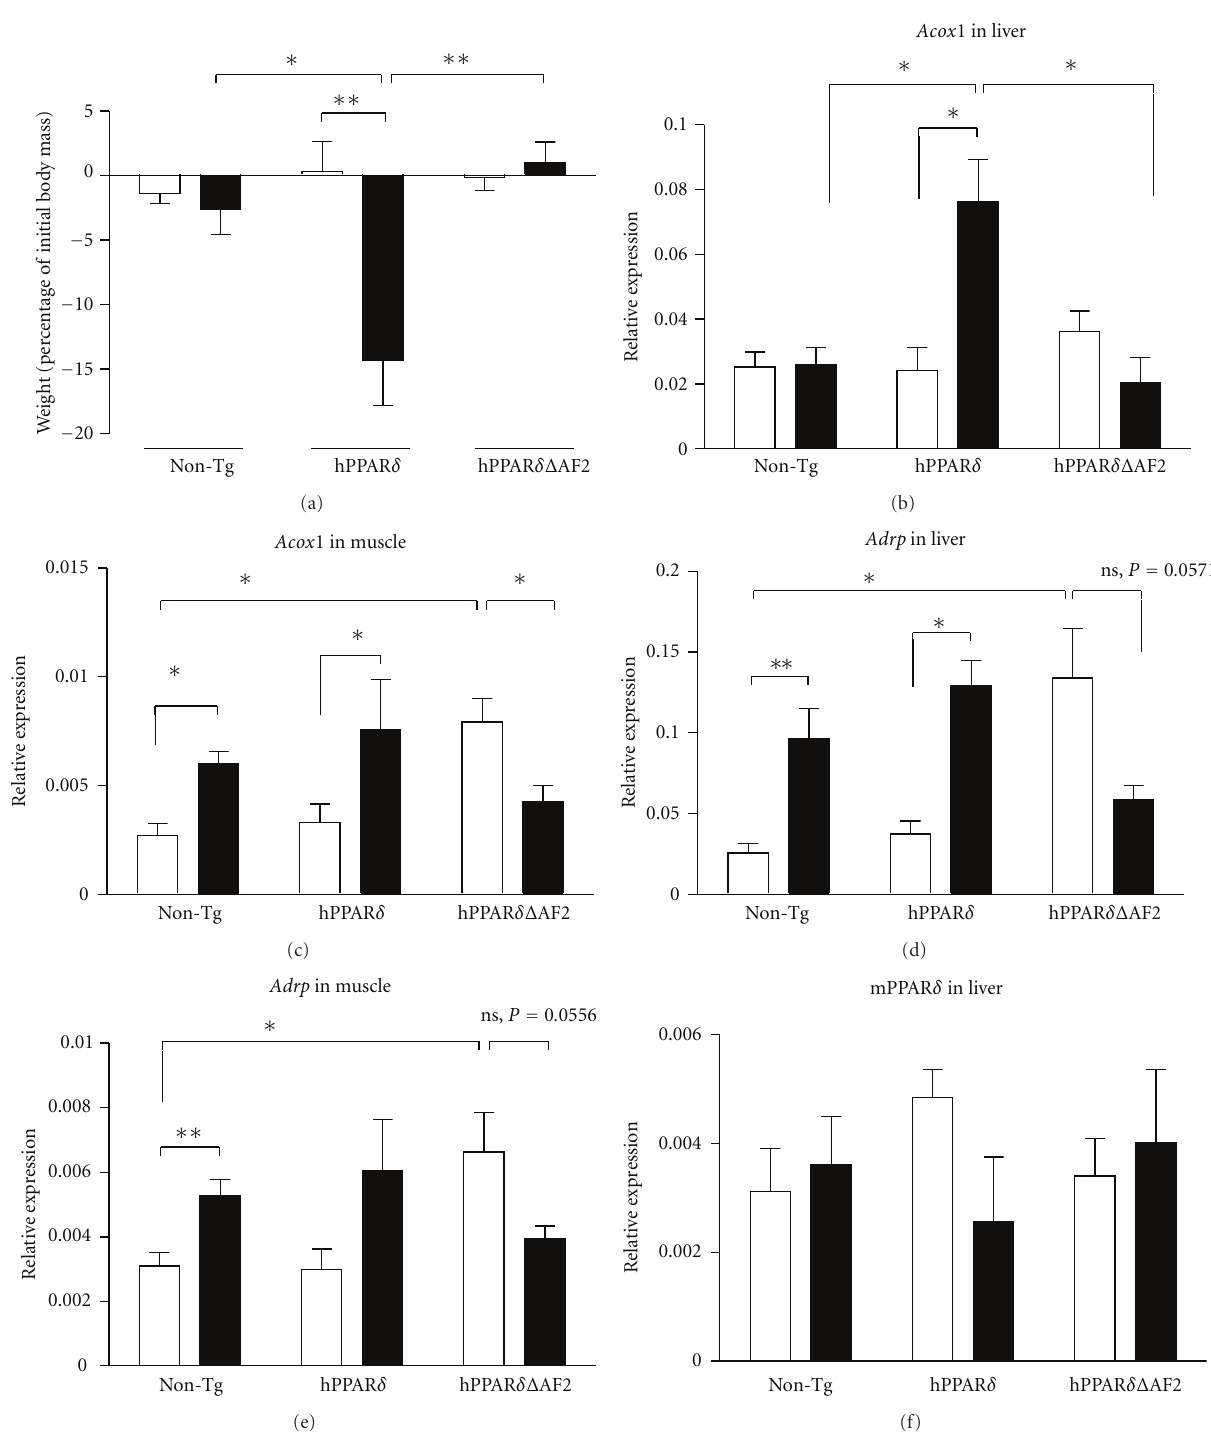
Figure 3: Mice expressing functional hPPAR δ and hPPAR δ Δ AF2 protein. Animals ( n = 5 per group, 12 weeks old, mixed males and females) were placed on a diet containing I3C (0.25% (w/w)) (open bars) or a diet containing I3C (0.25% (w/w)) and GW501516 (0.0025% (w/w)) (black bars) for 14 days. (a) body weight of nontransgenic (Non-Tg), hPPAR δ and hPPAR δ Δ AF2 transgenic mice expressed as a percentage of initial body weight. (b–f) mRNA expression of Acox1 in liver (b), muscle (c), mRNA expression of Adrp in liver (d), muscle (e), and mouse endogenous PPAR δ (f) following treatments outlined above. Statistical significance ( ∗ P ≤ 0 . 05; ∗∗ P ≤ 0 . 01; ∗∗∗ P ≤ 0 . 001) where indicated was analysed using Mann-Whitney non-parametric test in GraphPad Prism version 5.0c, (GraphPad Software, San Diego, CA,